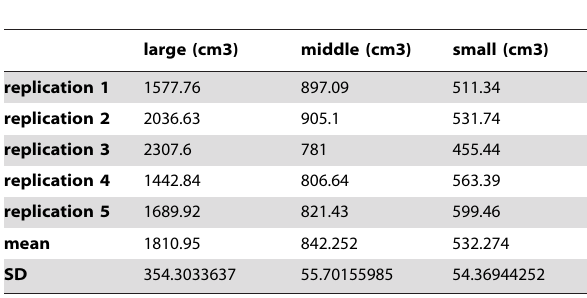
Table 3. Volume results of artificial models from 5 analyses.